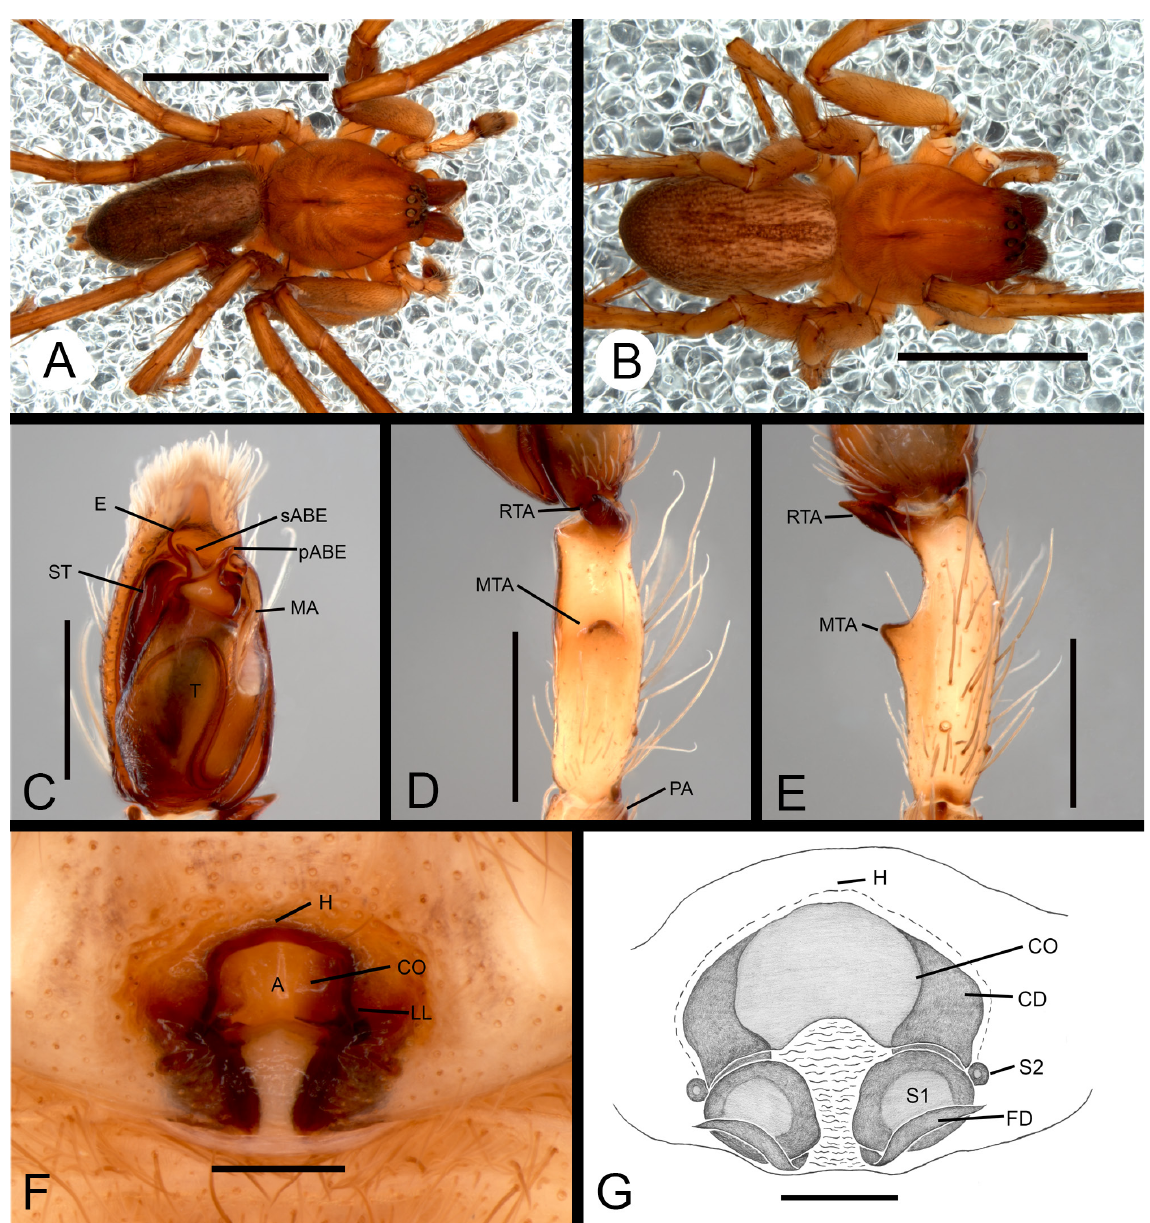
Fig. 30. Tafana orinoco sp. nov. (A, C–E = holotype, ♂, MIZA 07062; B, F–G = paratype,♀, MIZA 07062). A . Habitus, dorsal view. B . Habitus, dorsal view. C . Left palp, ventral view. D . Left palp, retrolateral view. E . Left palp, dorsal view. F . Epigynum, ventral view. G . Vulva, dorsal view. Abbreviations: A = atrium; CD = copulatory ducts; CO = copulatory opening; E = embolus; FD = fertilization ducts; H = hood; LL = lateral lobes; MA = median apophysis; MTA = median tibial apophysis; PA = patellar apophysis; ABE = primary apophysis of base of the embolus; RTA = retrolateral tibial apophysis; S1 = primary spermathecae; S2 = secondary spermathecae; sABE = secondary apophysis of base of the embolus; ST = subtegulum; T = tegulum. Scale bars: A–B = 3.5 mm; C = 0.5 mm; D–E = 0.66 mm; F–G = 0.25